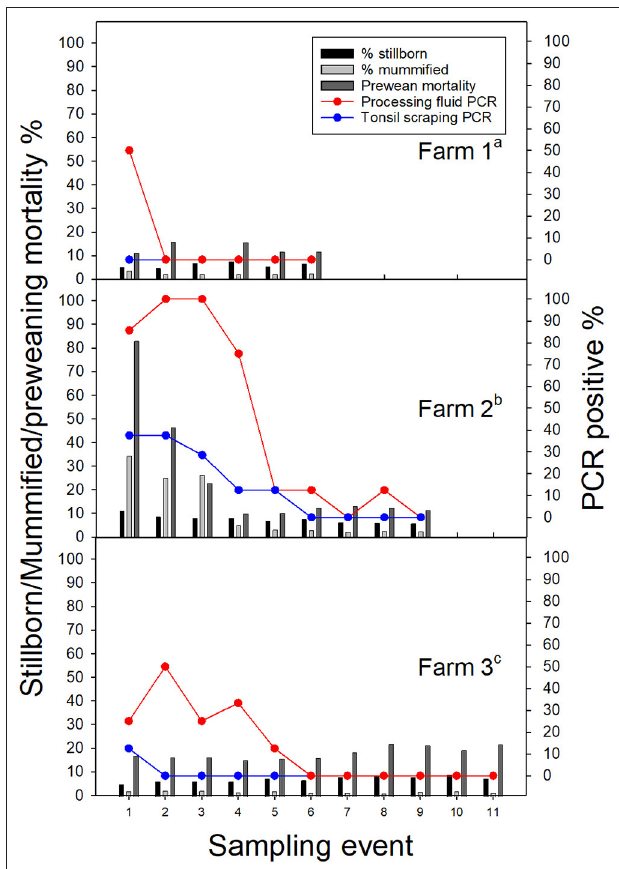
FIGURE 1 | Porcine reproductive and respiratory syndrome virus (PRRSV) positive rate (%) in processing fluid and tonsil scraping specimens by stillborn fetus (%), mummified fetus (%), and pre-weaning pig death rates (%) in three breeding farms. a Farm 1. Latest PRRSV outbreak, ∼ 6 months prior to the first sampling event. b Farm 2. Latest PRRSV outbreak, < 1 month prior to the first sampling event. Vaccinated with a modified live vaccine (Fostera ® PRRS, Zoetis Inc). c Farm 3. Vaccinated with a modified live vaccine (Ingelvac PRRS ® MLV, Boehringer